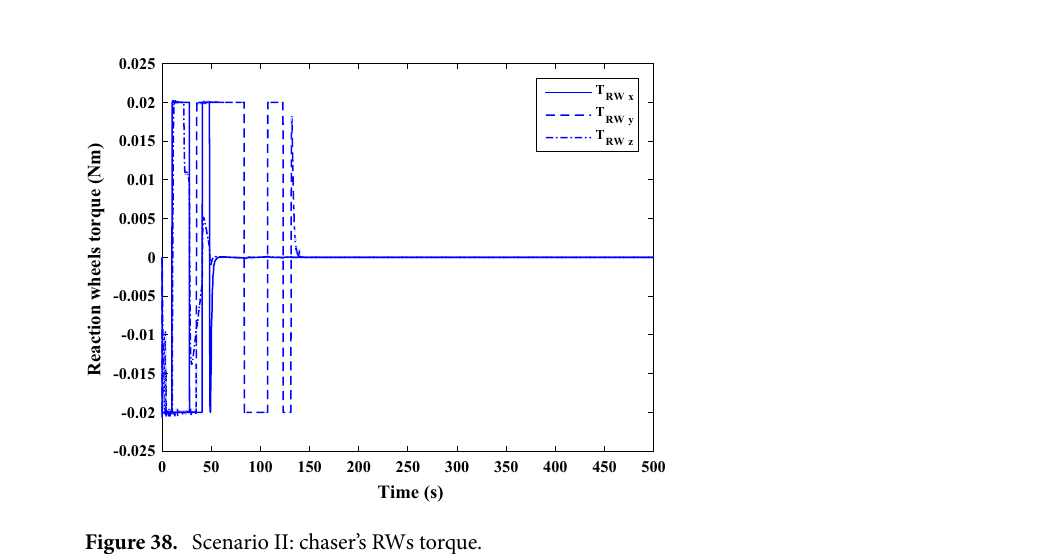
Figure 37. Scenario II: chaser control torque.